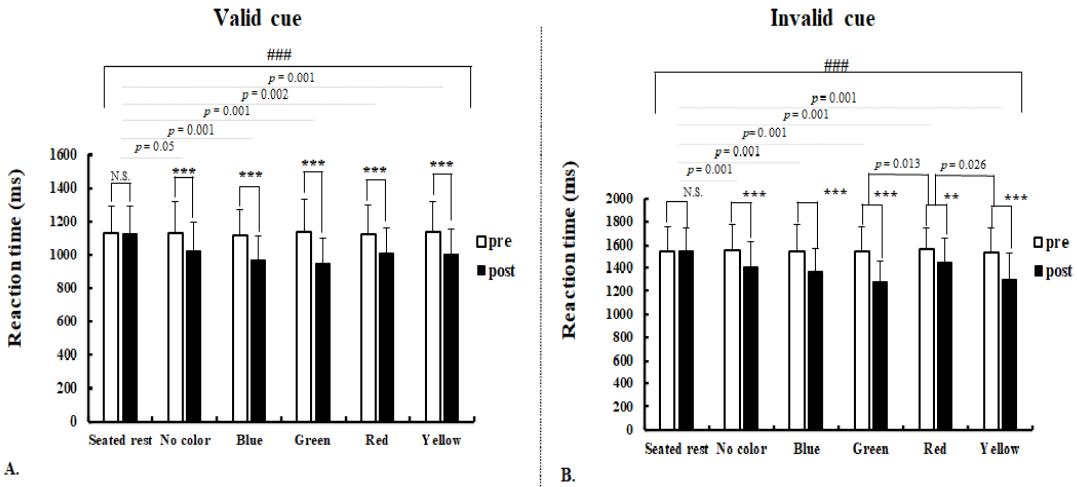
Figure 3. Response time (RT) during the Kanizsa triangle task in seated-rest and pre and post exercise with five different interventions (i.e., colors). ( A ) valid cue; ( B ) invalid cue. Note : ***, significant difference in pre vs. post at p < 0.001; **, significant difference in pre vs. post at p < 0.05; ###, significant interaction on RT changes between five interventions at p < 0.001; N.S., non-significant ( p > 0.05).